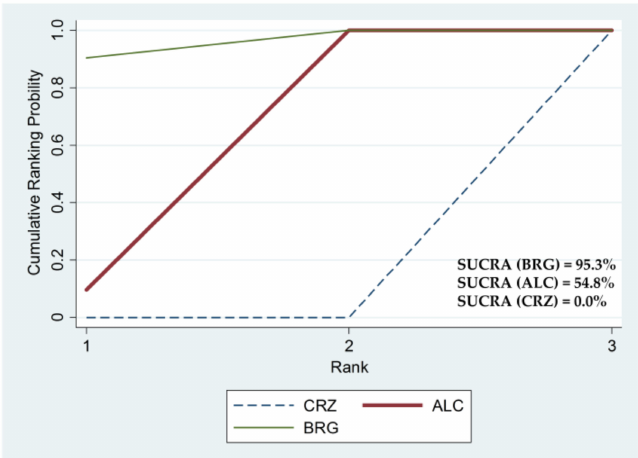
Figure 4. Surface under the cumulative ranking (SUCRA) curve for non-small cell lung cancer (NSCLC) with central nervous system (CNS) metastasis. SUCRA values are expressed as percentages of the areas under the curve, with higher SUCRA values indicating better treatment. BRG, brigatinib; ALC, alectinib; CRZ, crizotinib.